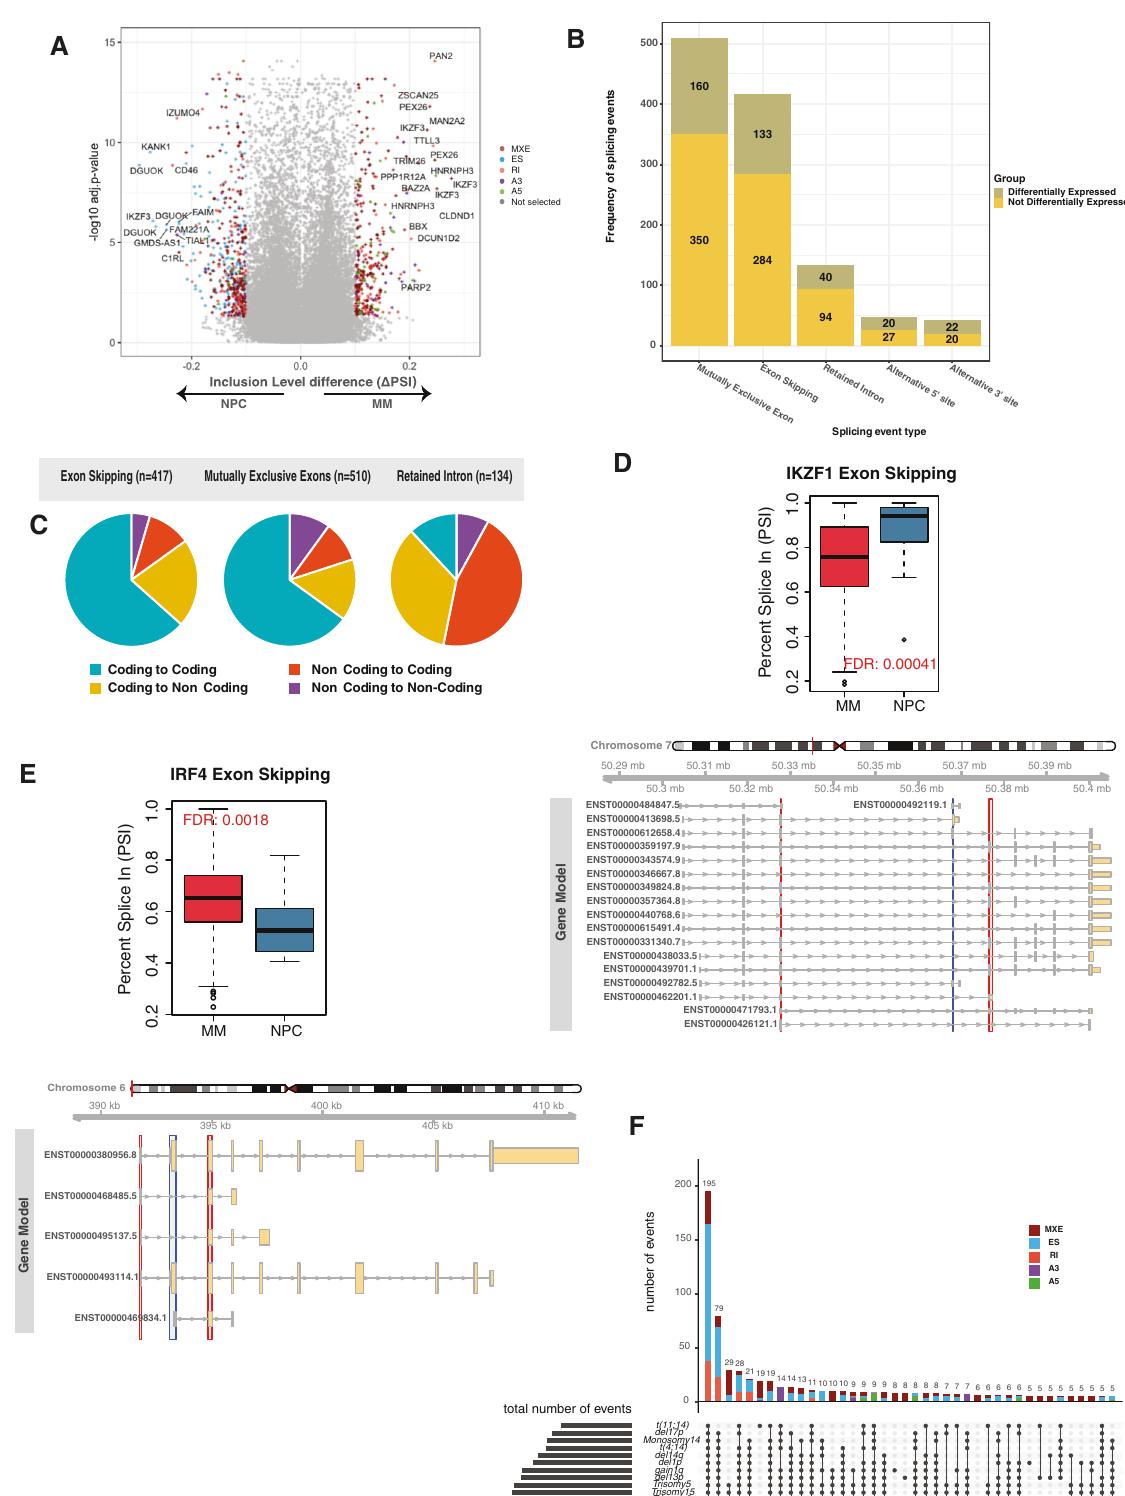
We further delineated the role of SRSF1 in promoting MM cell growth and survival by inducing ectopic expression of SRSF1 in the KMS20 cell line, which has low endogenous SRSF1 levels. Overexpression of SRSF1 led to a signi fi cant increase in MM cell proliferation compared to control cells in vitro (Fig. 3F) and